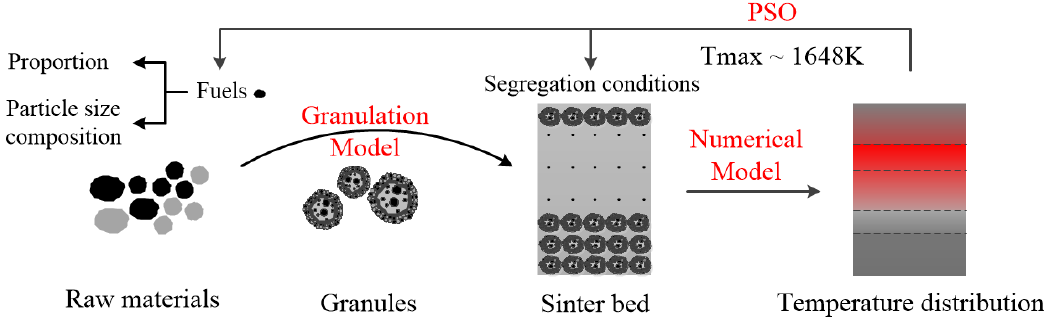
Figure 2. The general strategy framework.